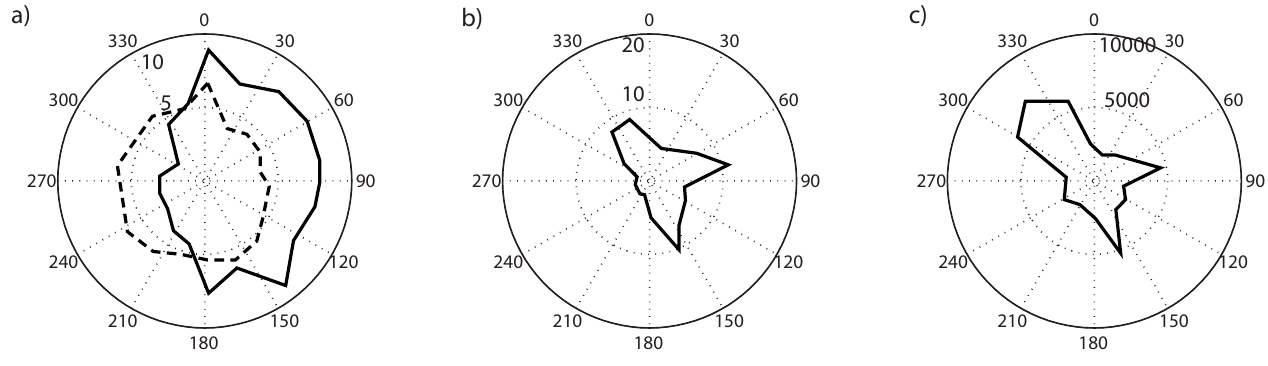
( a ) Distribution (given in %) of landslide numbers as a function of slope orientation (solid line). The slope distribution of the study area is shown as reference with a dashed line. ( b ) Distribution of landslide area (given in %) as a function of slope orientation. ( c ) average landslide area (m 2 ) as a function of the slope